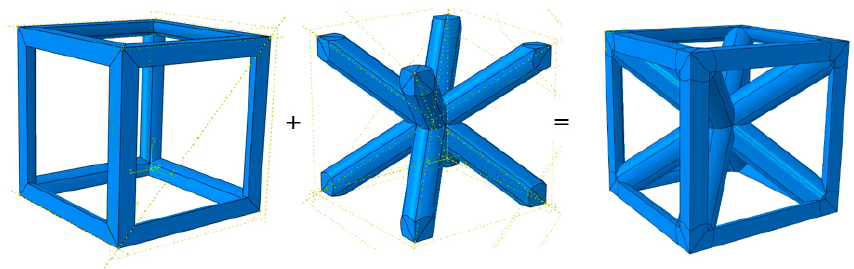
Figure 1. Combining frame and body-centered cubic (BCC) unit cells to develop an InsideBCC unit cell.